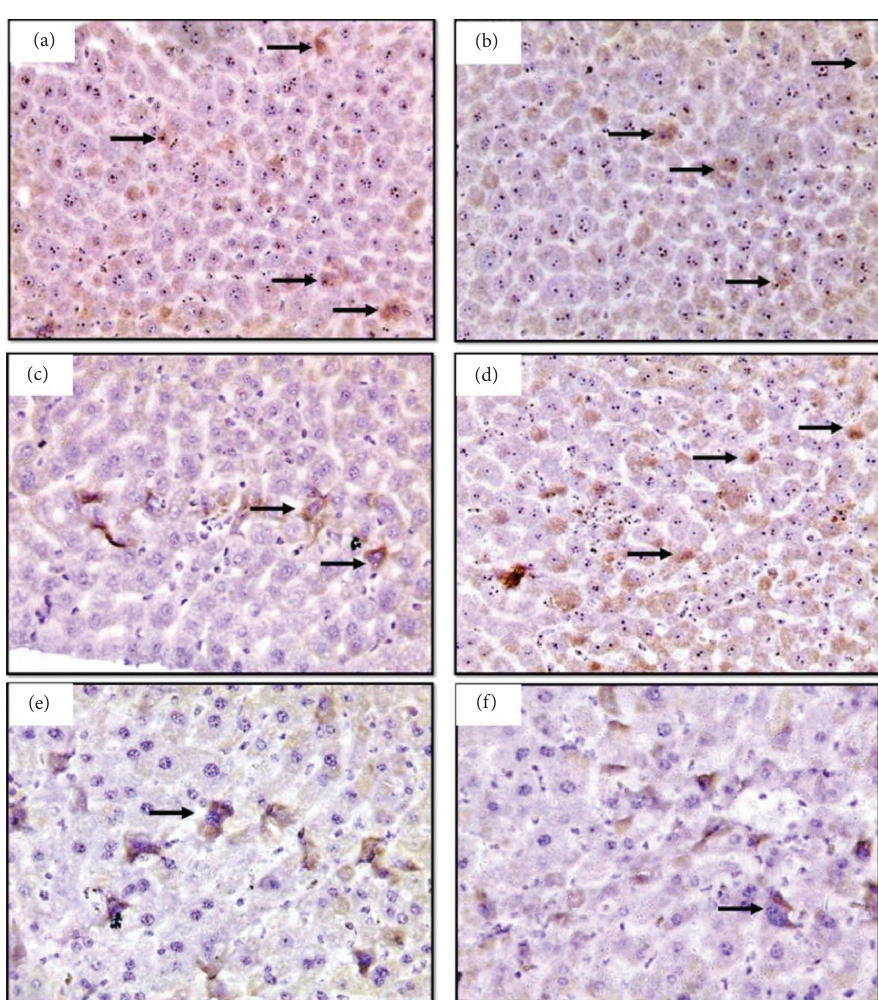
Figure 4: Liver section in mice showing immunohistochemical staining method detection of Bcl-2 stained positive cells. Tere are many positive cells (brown stain) in the control group (a), (b) treated with ZnCl 2 10 mg/k and (d) treated with ZnCl 2 10+CdCl 2 1.5mg/k groups. (c) Treated with CdCl 2 1.5mg/k, there are few positive cells. (e) Treated with CdCl 2 3mg/k and (f) treated with ZnCl 2 10+ CdCl 2 3mg/k showed a decreased in immunoreaction, 40x.